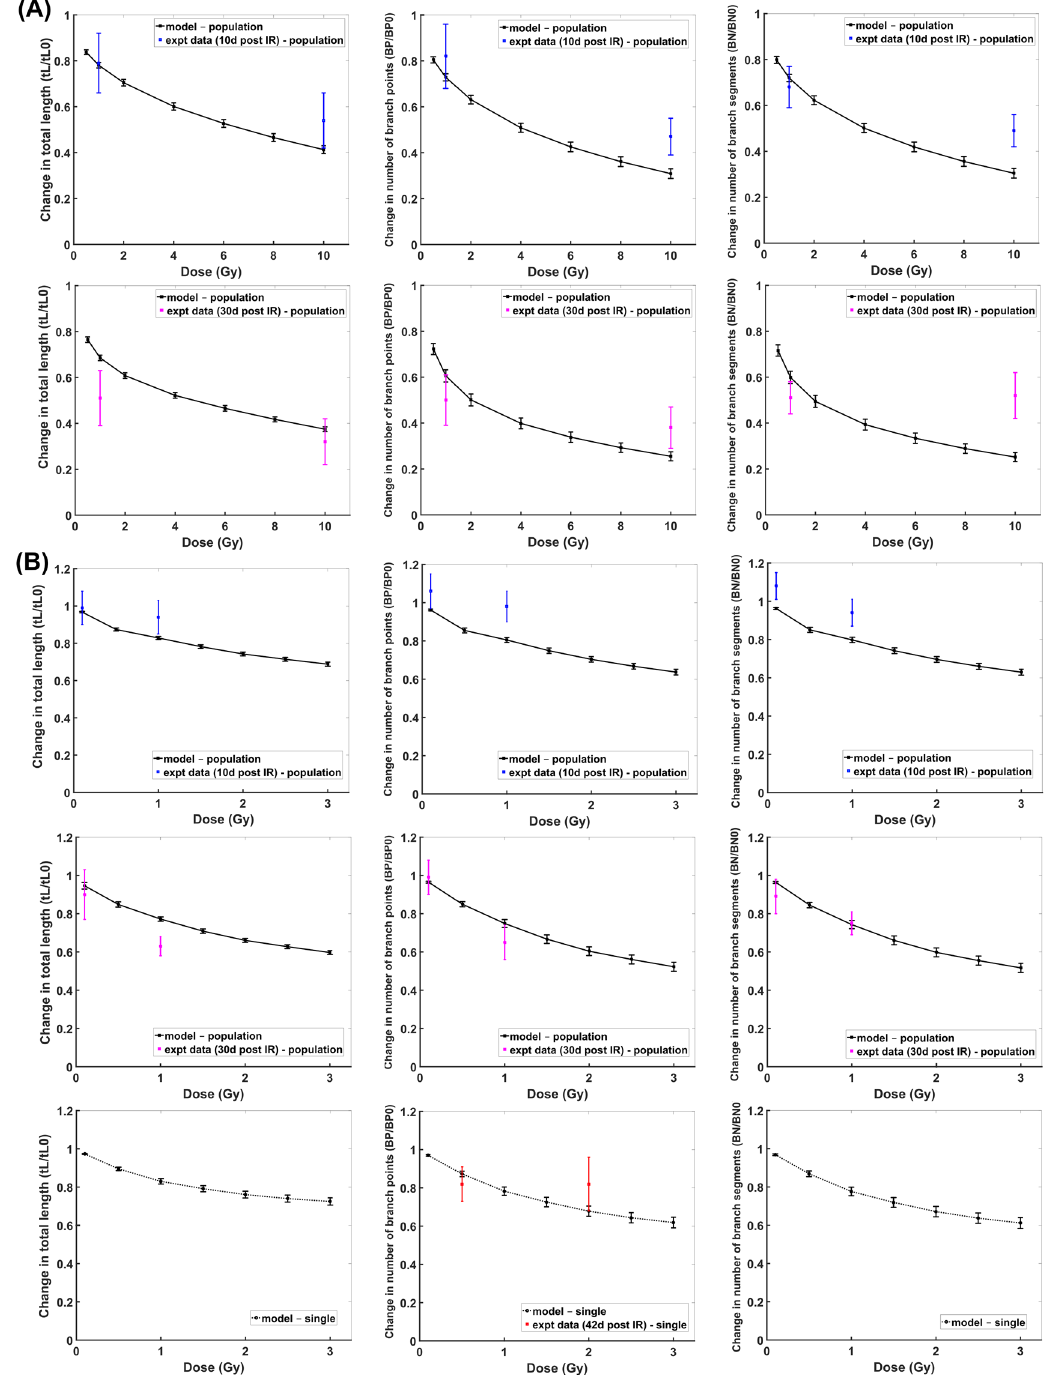
Figure 3. Comparison of modeling results with experimental data: Dose-dependent GCL neuron dendritic damage induced by gamma rays ( A ) and proton radiation ( B ) at 10 days (blue), 30 days (magenta) and 42 days (red) post exposure (solid line represent damage on population of neurons while dashed line represent damage on single neuron; error bar represents standard error of the mean for both modeling and experimental